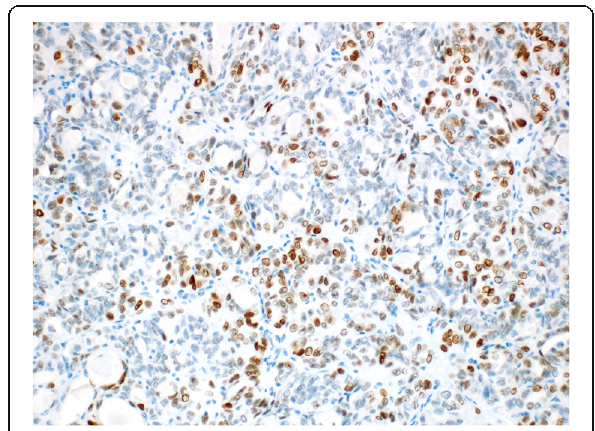
Fig. 6 Mesonephric-like adenocarcinoma showing focal TTF1 staining